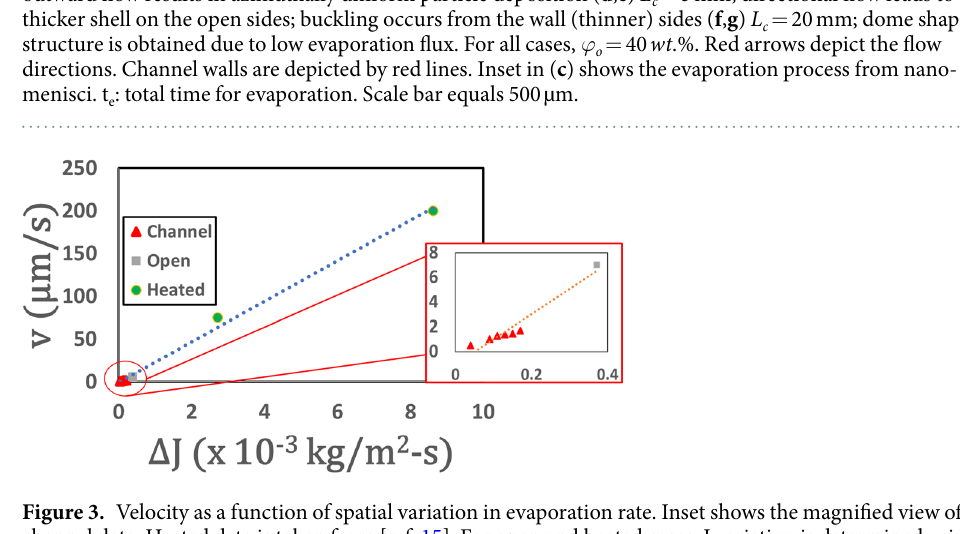
Secondly, non-uniform evaporation pattern in the azimuthal direction changes the flow field from recircu- lating toroidal (unconfined) to directional (towards the open side of the channel; Figs 1g and 2d). As a result, there is azimuthally varying particle deposition, the maximum being at the droplet surface closer to the open side (Fig. 2e). Subsequently, buckling location is shifted from the top sector (Fig. 4a) towards the droplet surface near the channel walls (Fig. 4b–e). Furthermore, for short channels, buckling is followed by rupturing (Fig. 4b,c). However, with an increase in L c , buckling tendency subsequently is arrested, with a complete suppression beyond a critical length (Fig. 4f and inset 4 (ii)). How can we explain the physics of the phenomena depicted as above? Towards addressing this, we first note that pure water droplet (confined or unconfined) exhibits three modes of evaporation namely, constant contact